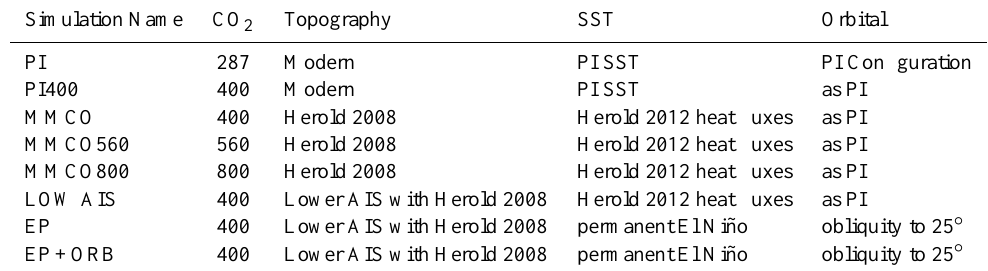
Table 1. Simulation names and boundary conditions for the PI and MMCO